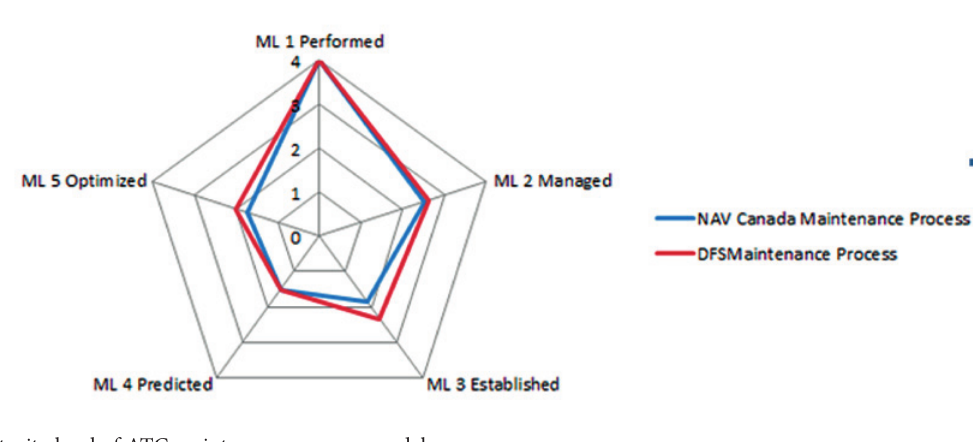
Fig. 5. Maturity level of ATC maintenance process model